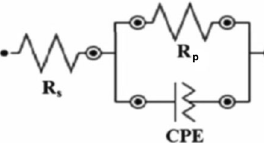
temperatures (Fig. 7). The curve’s shift for a lower current density indicates that the molecules’ adsorption on the metal surface slowed down the corrosion process. In addition, the inclusion of an inhibitor to the blank solution results in a reduction in the values of I corr . In the absence of the studied inhibitor, I corr was 286.2 (µA cm −2 ), which increased to reach 71.2 (µA cm −2 ) at 25 °C in the occurrence of 20 mM Ampicillin drug suggesting the adsorp- tion of drug molecules on the metal surface. The results of the polarization curve verified that the increasing